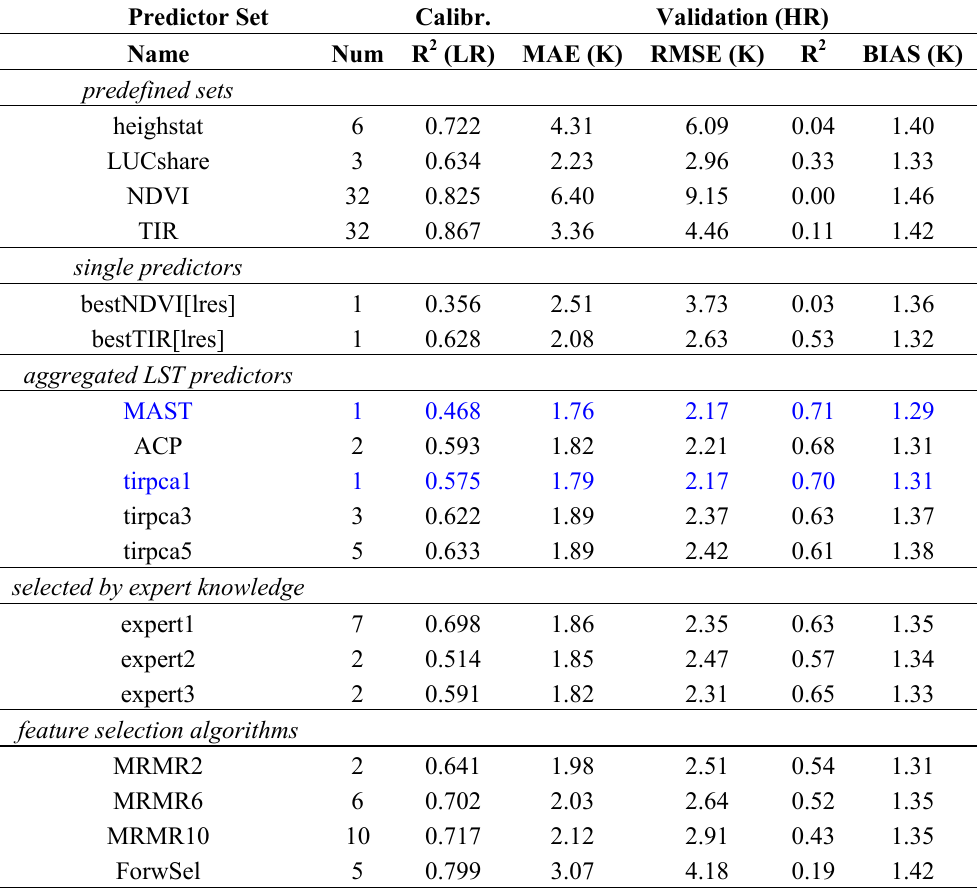
Table 1. Downscaling accuracy with linear regression for different predictor sets. Number of predictors in the set (Num), explained variance (R 2 ) of the model in LR domain, mean absolute error (MAE), root mean square error (RMSE), R 2 and BIAS for the independent validation data in HR domain. Best predictor sets are highlighted